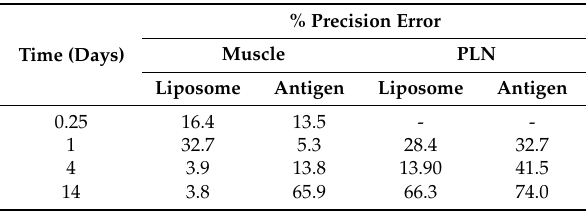
Table 3. Precision error